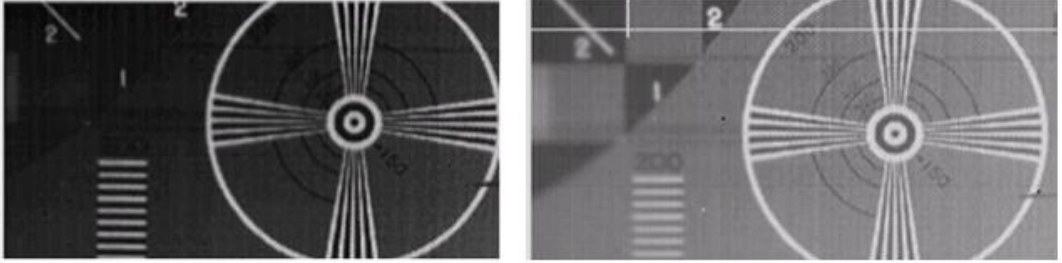
Figure 9. Full fill factor blanket i-Si photodiode array ( Left ) compared to pixel pattern photodiode array ( Right ).